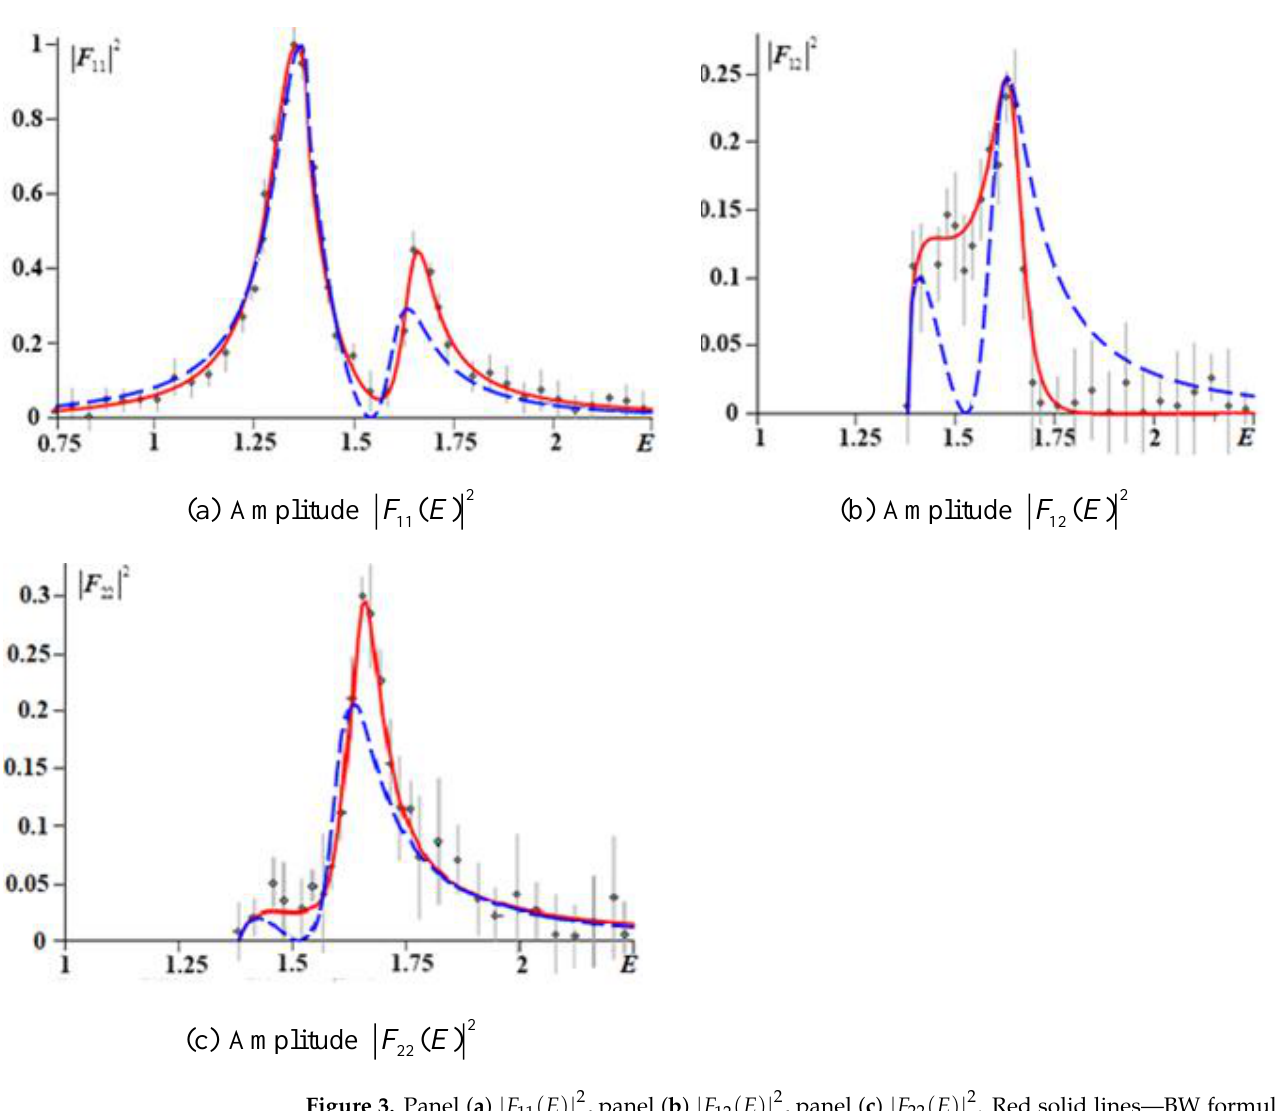
Figure 3. Panel ( a ) | F 11 ( E ) | 2 , panel ( b ) | F 12 ( E ) | 2 , panel ( c ) | F 22 ( E ) | 2 . Red solid lines—BW formula Figure 3. Panel (a) . Red solid lines — BW (44), blue dashed lines— K -matrix Equation (46); threshold E 2 = formula (44), blue dashed lines — К -matrix Equation (46); threshold